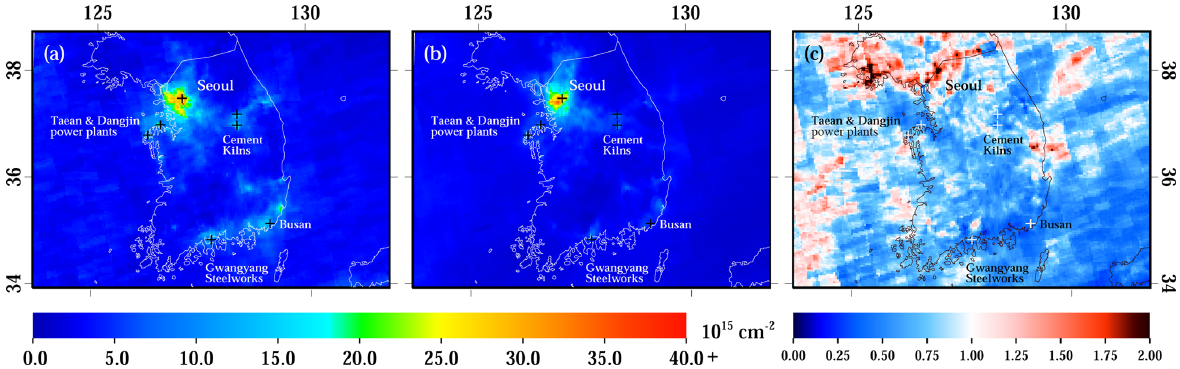
Figure 10. Same as Fig. 3, but now showing the WRF-Chem simulation with NO x emissions in the Seoul metropolitan area increased by a factor of 2.13 in panel (b)